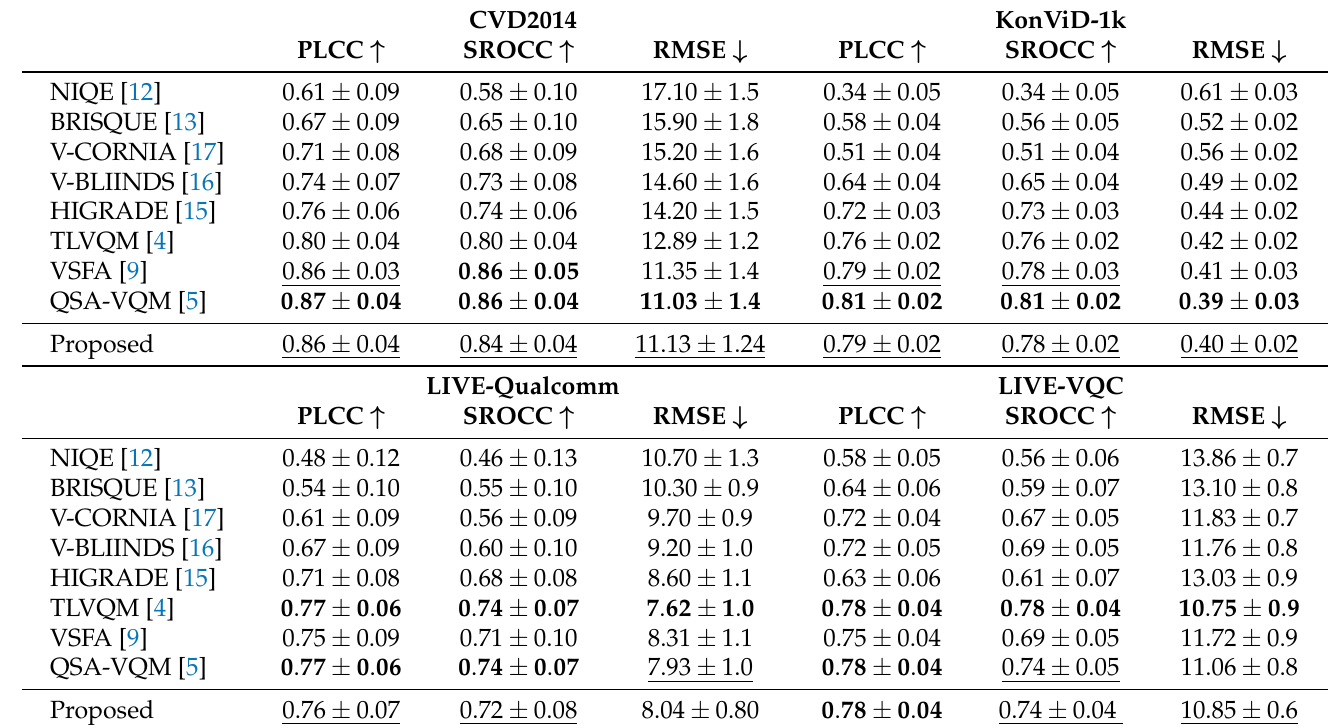
Table 2. Mean Pearson’s Linear Correlation Coefficient (PLCC), Spearman’s Rank-order Correlation Coefficient (SROCC), and Root Mean Square Error (RMSE) across 100 train–test combinations on the four considered databases. In each column, the best and second-best values are marked in boldface and underlined,